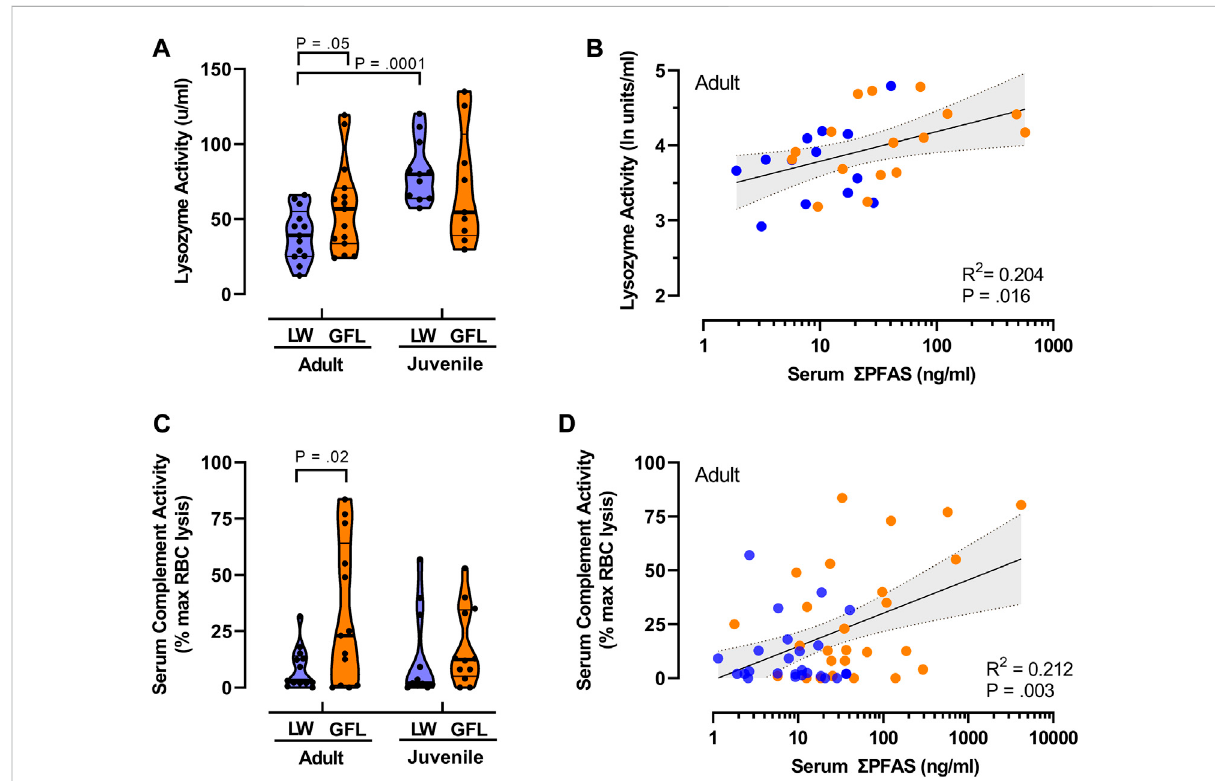
FIGURE 2 Relationships between PFAS exposure and innate immune functions. (A) Violin plots comparing median lysozyme activity in juvenile (SVL < 90 cm) and adult American alligators (SVL > 90 cm) from Lake Waccamaw (LW; thick lines indicate median; thin lines indicate quartiles) and from the Green fi eld Lake (GFL) site on the Cape Fear River. Lake Waccamaw adult n = 13, juvenile n = 11; Green fi eld Lake adult n = 15, juvenile n = 9. (B) Relationship between total PFAS concentrations and lysozyme activity in adult alligators. Solid line is the best fi t linear regression, with shaded area represents 95% CI. n = 29. Reported p -value shown is for Pearson ’ s r. (C) Violin plots of complement activity in plasma samples of alligatorfromLakeWaccamaw(adult n =13;juvenile n =11)andGreen fi eldLake(adult n =13;juvenile n =12).ShownisthepercentofmaximalEDTA sensitive sheep red blood cell lysis activity (thick lines indicate median; thin lines indicate quartiles). (D) The liner regression and correlation between total PFAS concentrations and complement activity in adult alligators. ( n = 50). Reported p -value of Pearson ’ s r is